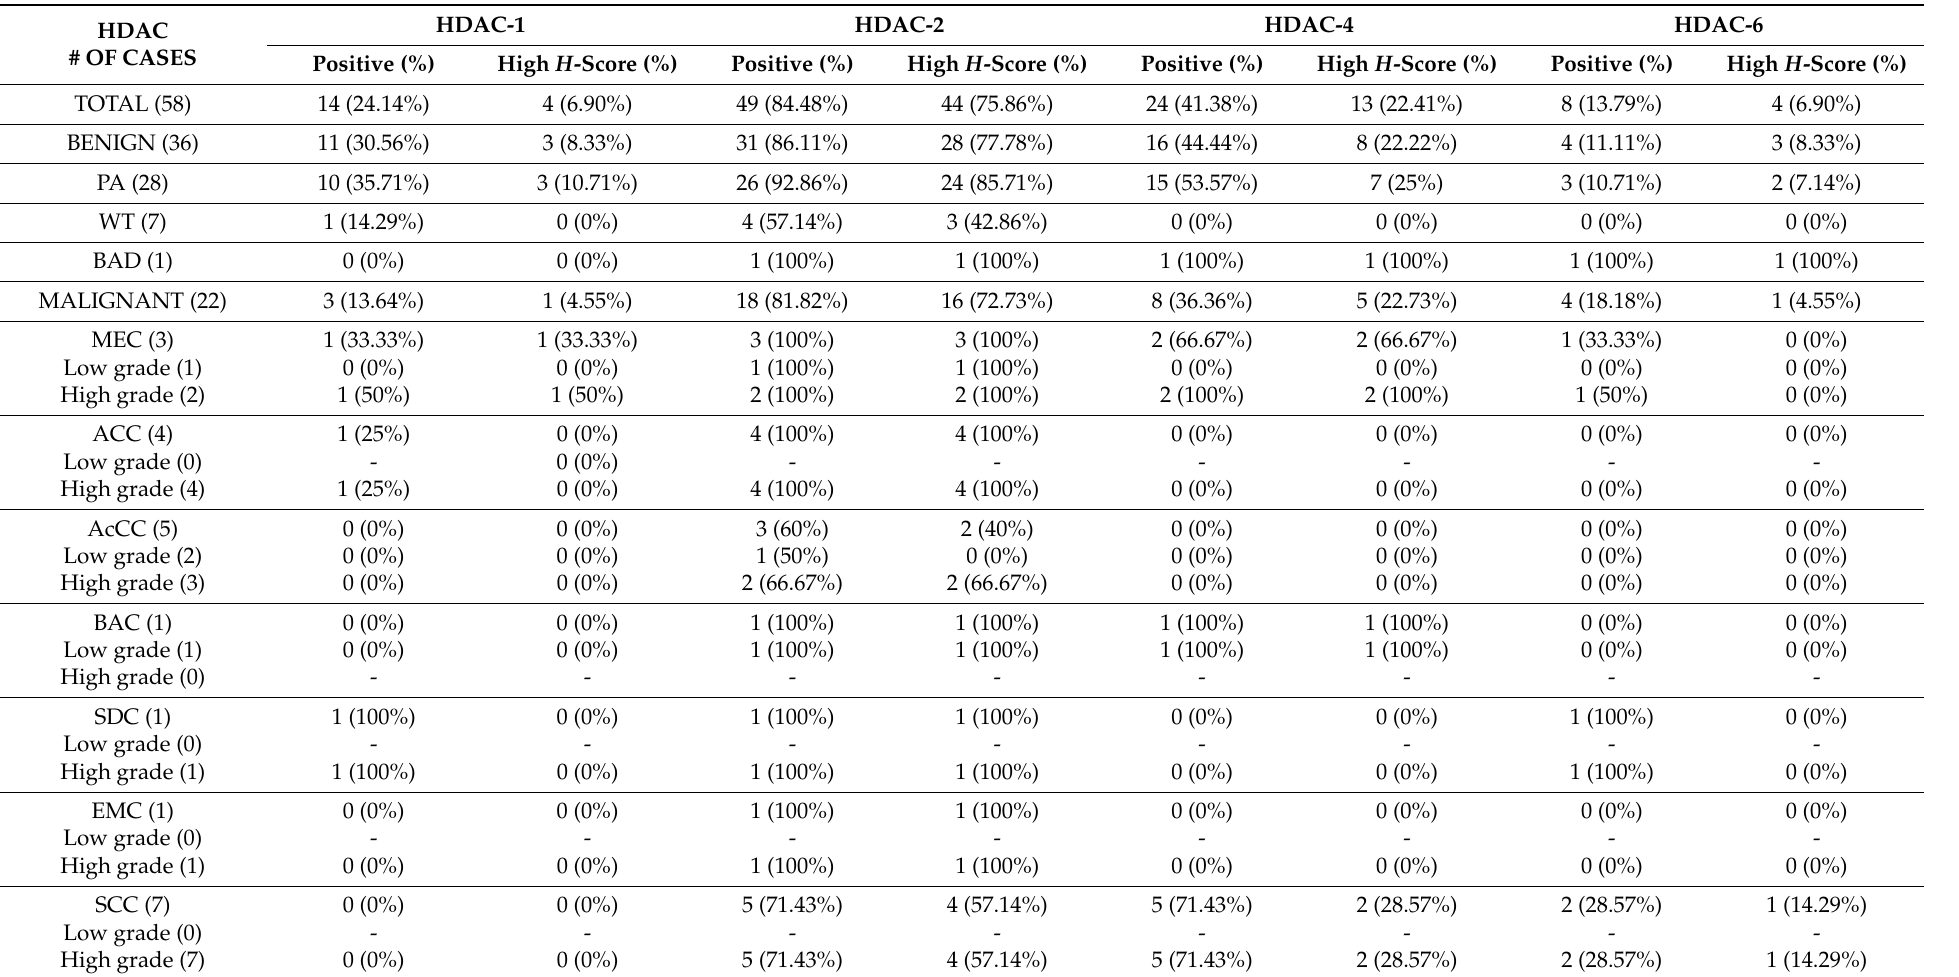
Table 1. Detailed results of the immunohistochemical analysis of HDAC-1, -2, -4 and -6 expression in